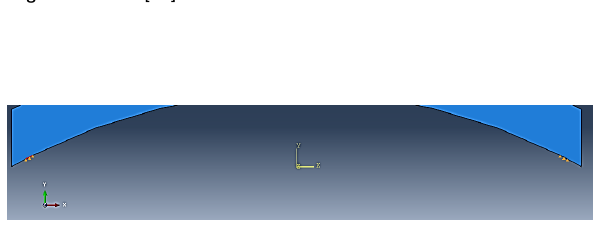
Figure 4: Numerical boundary conditions in the lower part of the segment